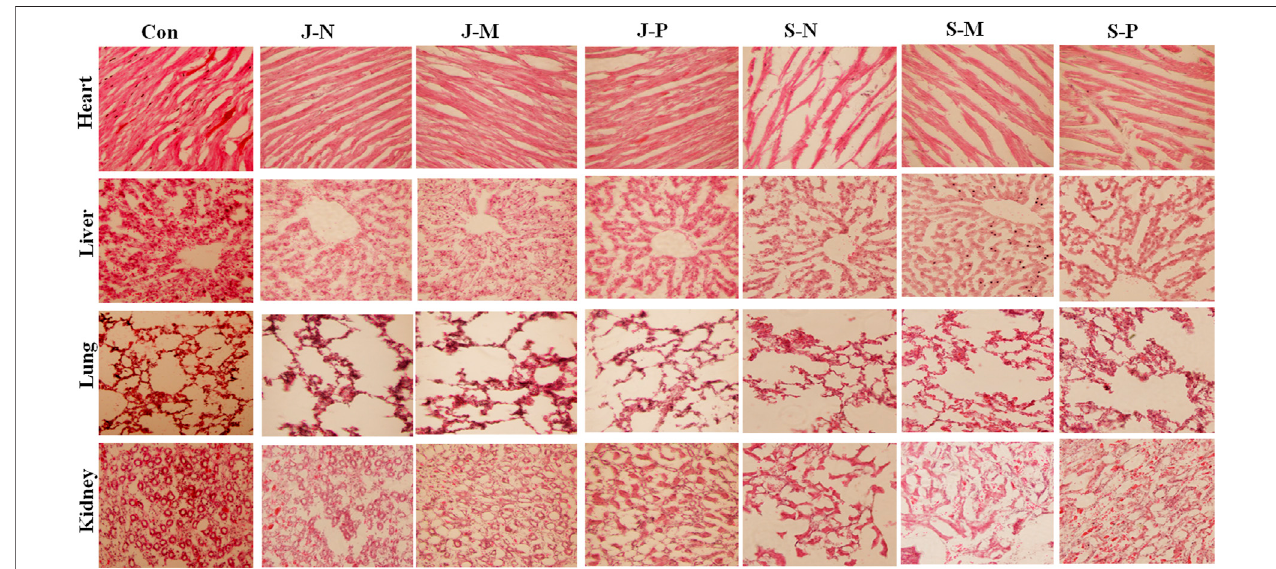
FIGURE 7 | The histomorphological features of New Zealand rabbits after different PAL treatments. HE-stained images showed no pathological changes in heart, liver, lung, or kidney tissue when compared with the control group.